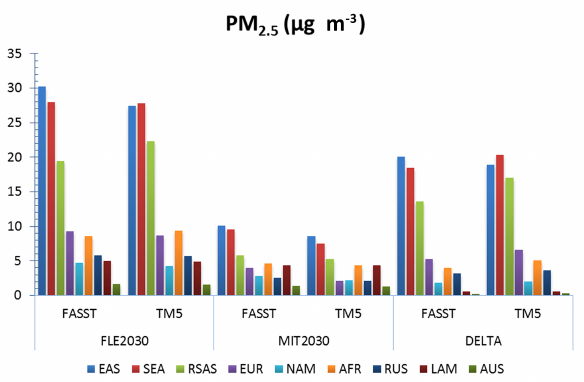
Figure 9. Total population-weighted anthropogenic PM 2 . 5 over larger FASST zoom areas, for the high-emission (FLE2030) and low-emission (MIT2030) scenarios, and the difference (delta) be- tween both, computed with the full TM5 model and with FASST.